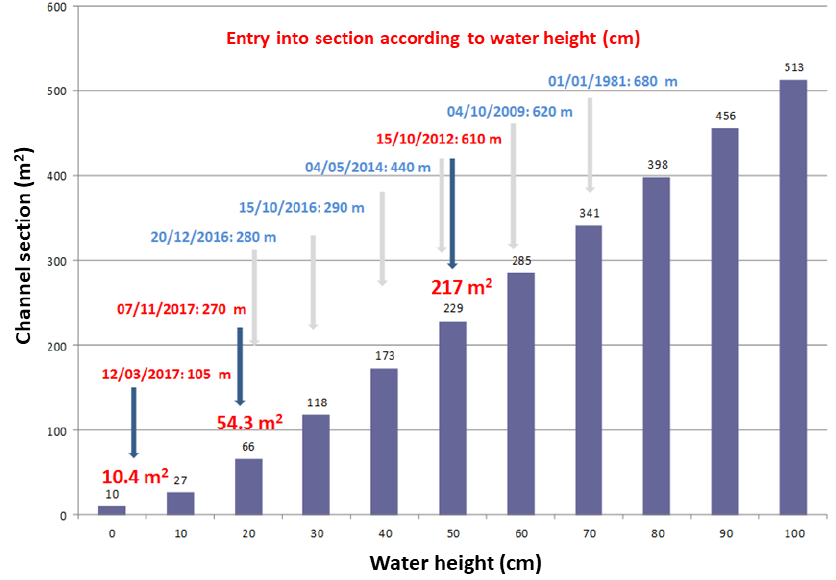
Figure 14. Water exchange section (m 2 ) in the Gola de las Encañizadas on different dates (values in red and blue) and for different water levels (m −2 ) induced by low atmospheric pressures (values in black) .